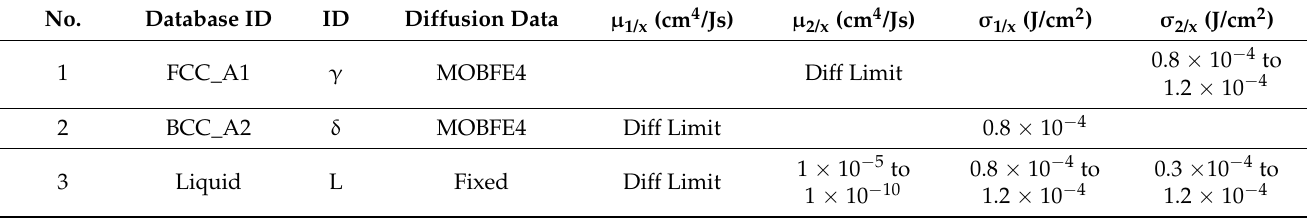
Table 2. Phases and phase-related